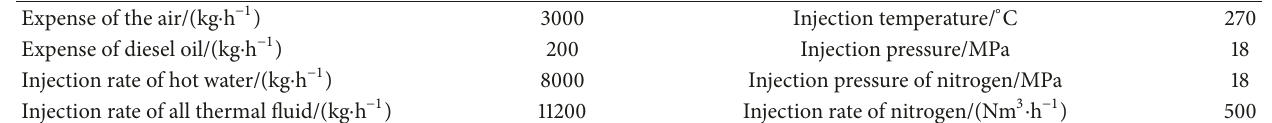
Table 3: Thermal injection parameter.